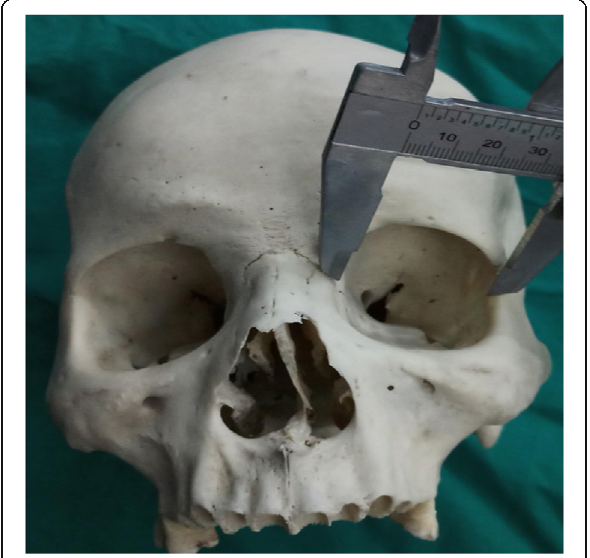
Fig. 2 The measurement of orbit breadth (OB): the distance between the dacryon and ectochion as the orbital